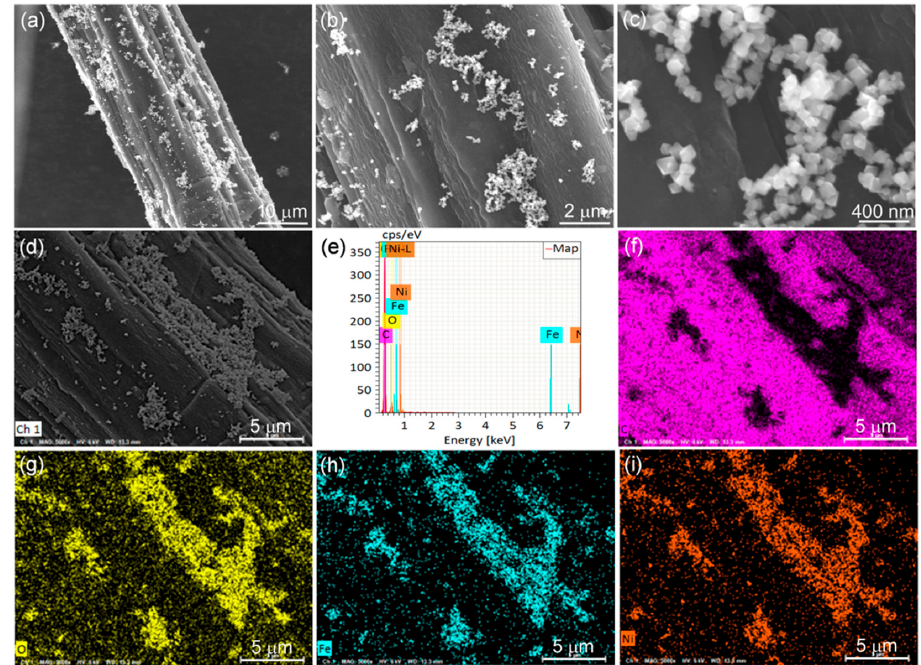
Figure 10. ( a – d ) SEM images, ( e ) EDX spectra, and ( f – i ) elemental mapping images of NiFe 2 O 4 /carbonized hemp fibers.